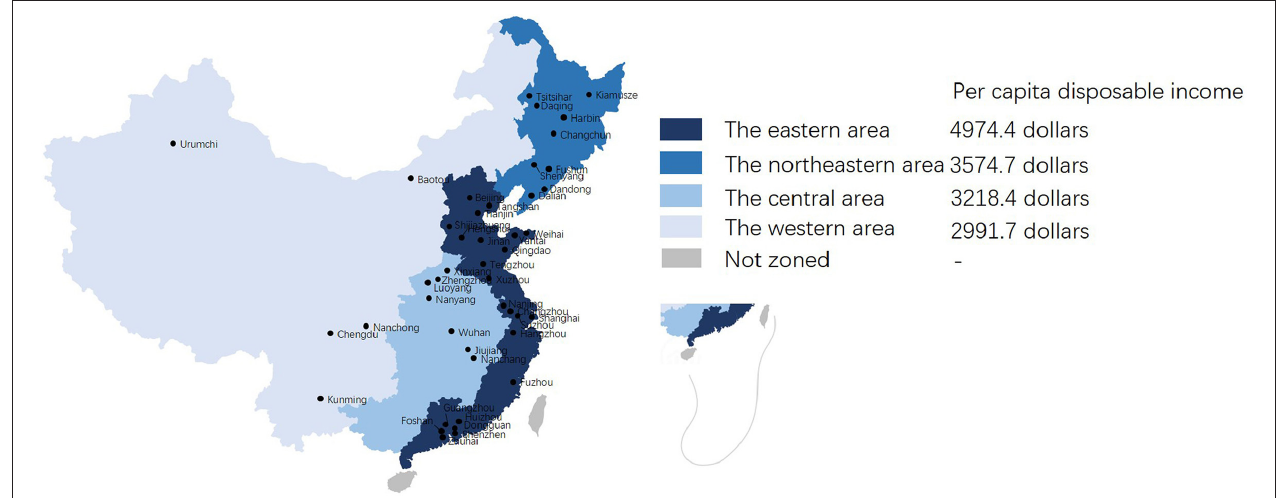
FIGURE 1 | Study site locations and division of geographical